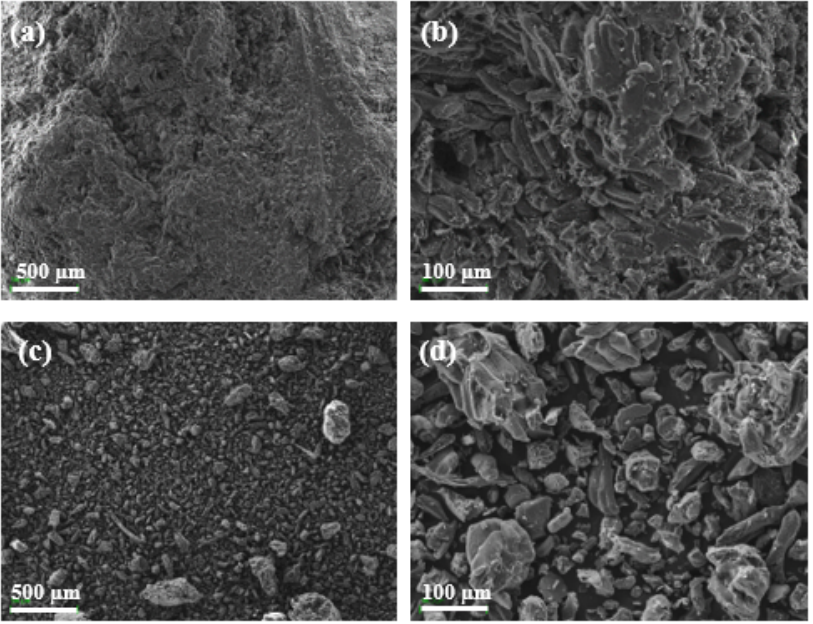
Figure 6. SEM images of OP samples: ( a ) not milled OP sample at 100 × ; ( b ) not milled OP sample at 500 × ; ( c ) milled OP sample at 100 × ; ( d ) milled OP sample at 500 × .